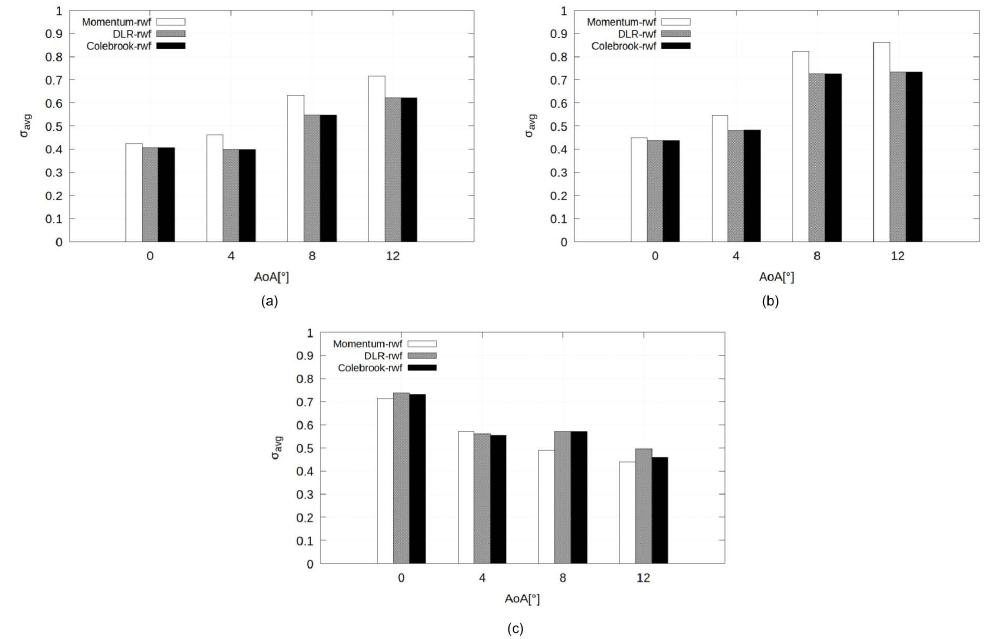
Figure 15. Average error between experimental and simulation results of C p distribution ( a ) case 1, ( b ) case 2, and ( c ) case 3.